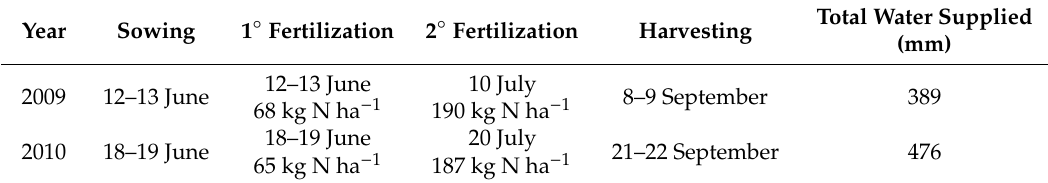
Table 2. The crop